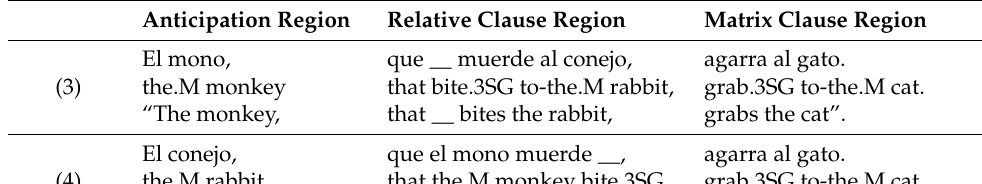
Table 3. Example stimuli from the SRC (3) and ORC (4) conditions.